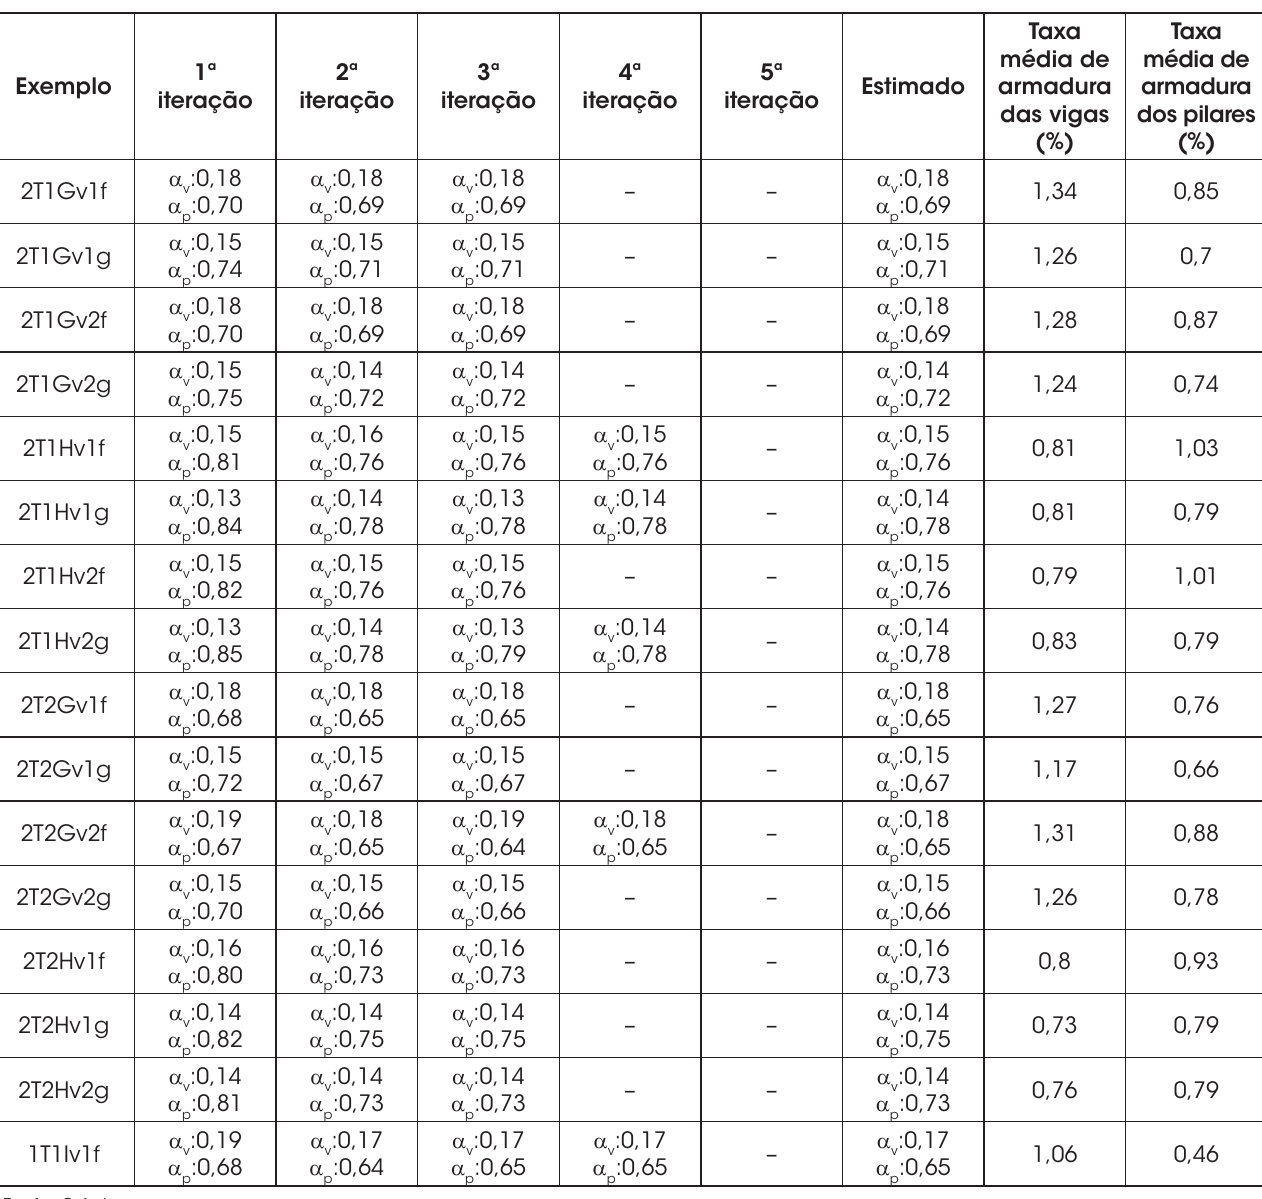
Resultados das simulações (parte